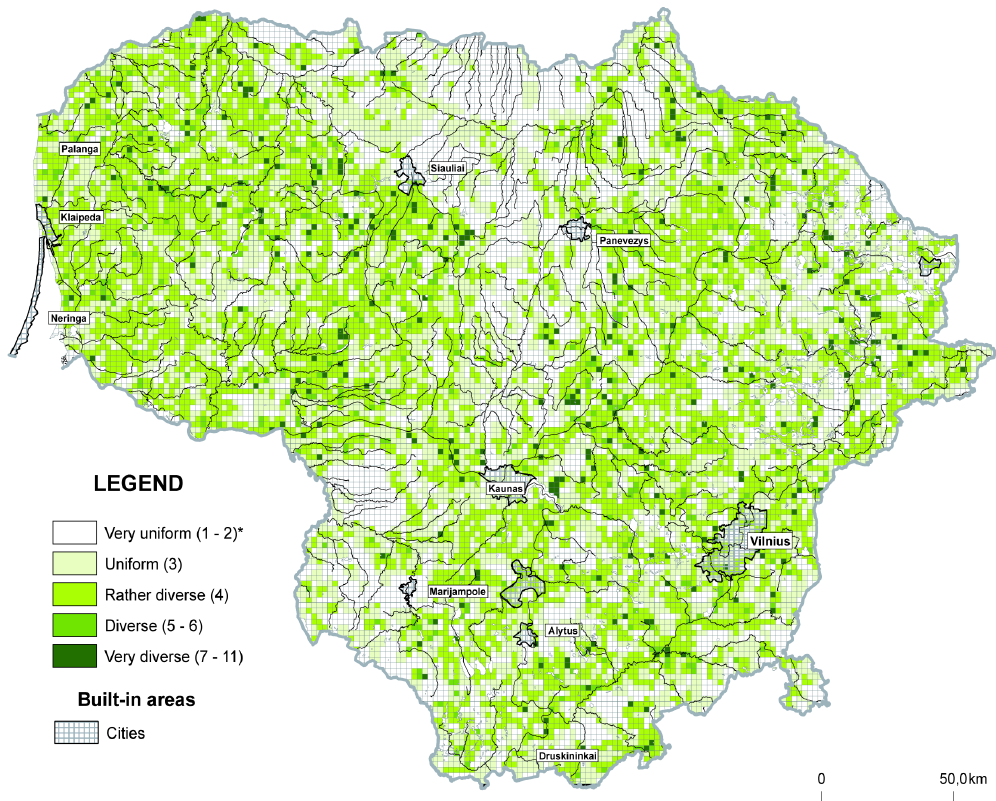
Fig. 3. Soil pH diversity in